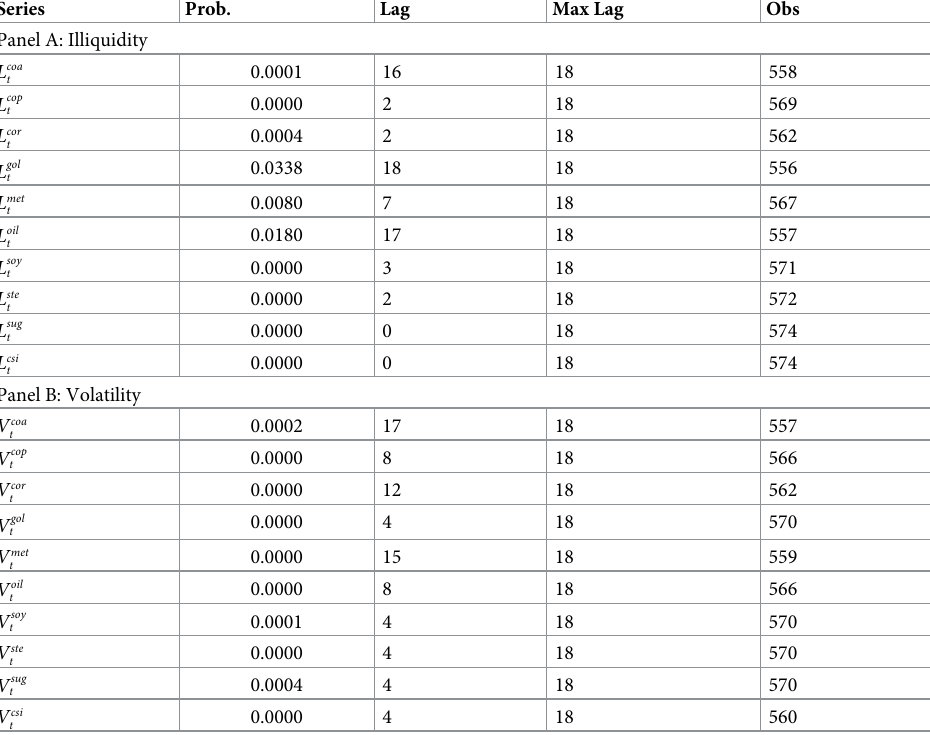
Table 2. Unit root test of illiquidity and volatility. The table presents the individual unit root test results for the illi- quidity and volatility of each market. Illiquidity is measured using the Amihud measure for each financial market. The sample runs from January 1, 2010 to March 22,